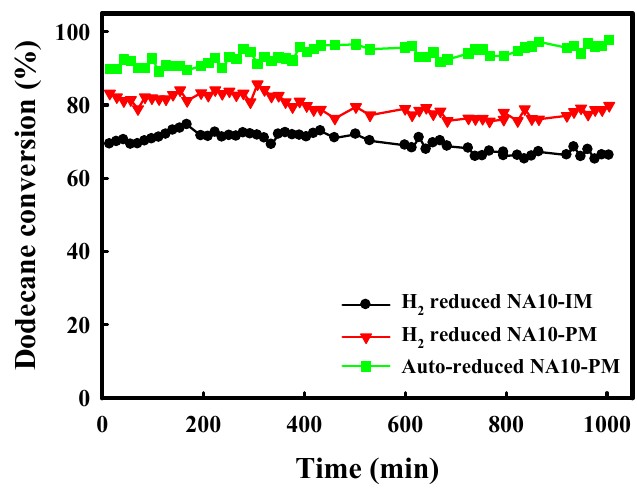
Figure 10. Stability comparison of the auto-reduced NA10-PM catalyst with the H 2 -reduced NA10-IM and NA10-PM catalysts under conditions of S/C = 1.23, O 2 /C = 0.25, and GHSV = 12,000 h − 1 at 750 ◦ C.